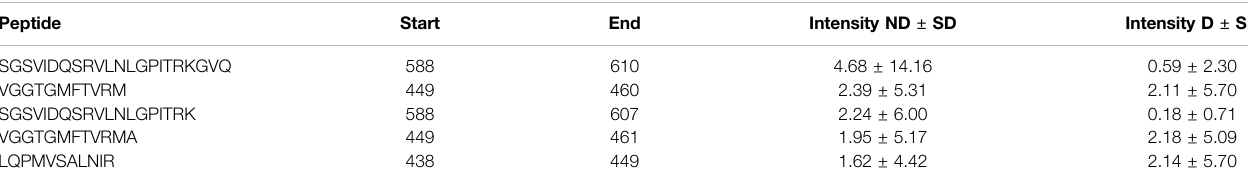
TABLE 4 | Peptide table for uromodulin (UROM_HUMAN). The table contains the fi ve most abundant peptides in both groups.